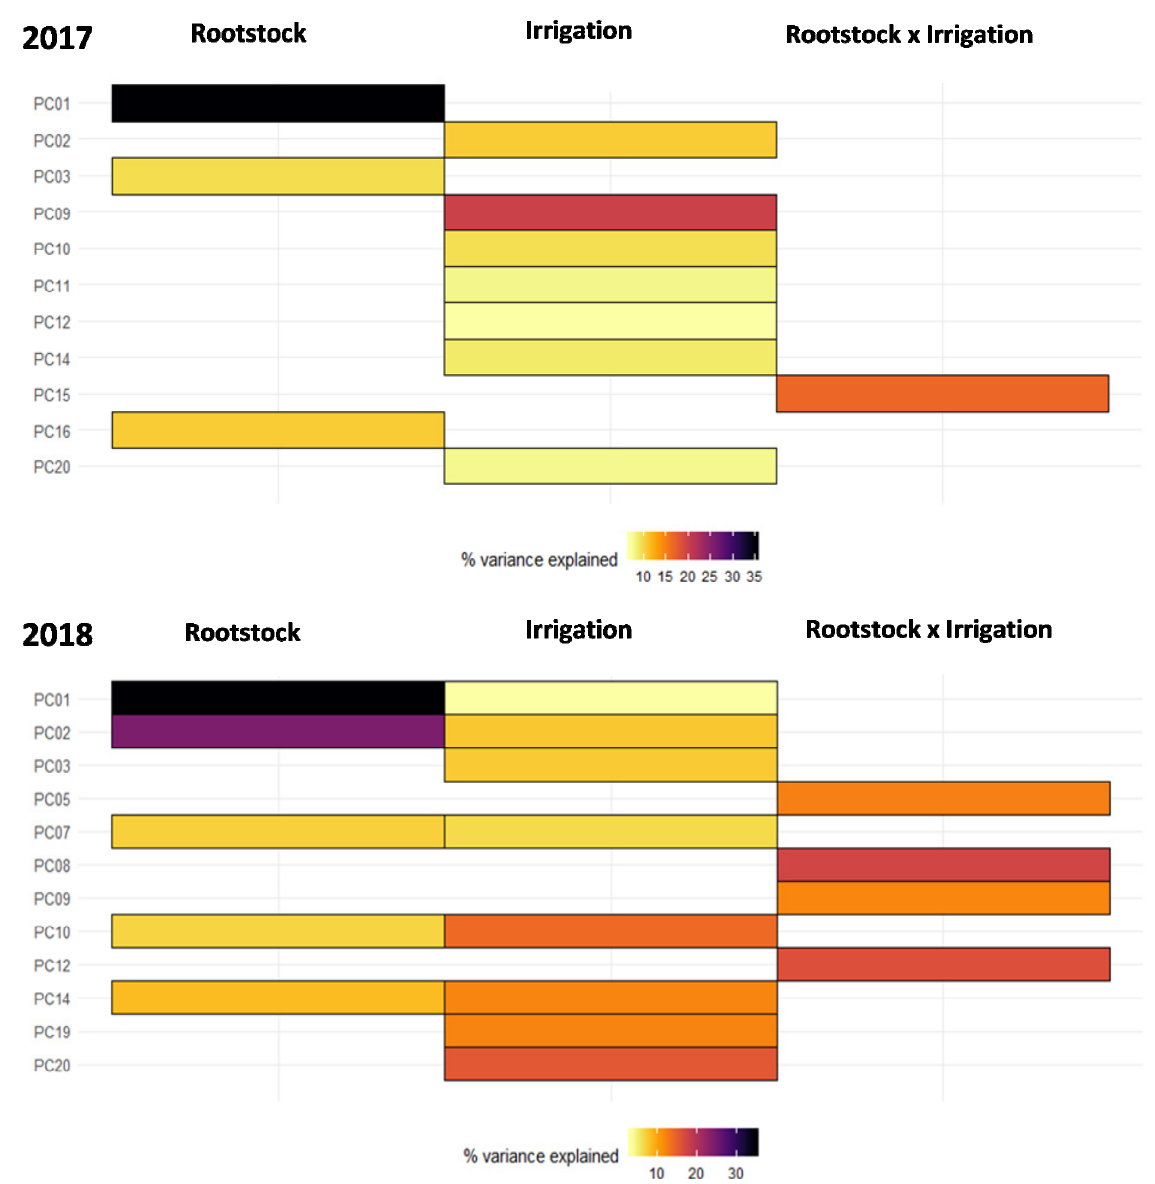
Figure 5. A linear model was estimated for wine 2017 and 2018 PCs 1 to 20. The model included rootstock (own-rooted, ‘1103P’, ‘3309C’, ‘SO4 ′ ), irrigation (Full, RDI, None), and rootstock by irrigation interaction. The 20 PCs capture 85.79% and 78.34% of the variance in 2017 and 2018. Only the factors which explained a significant portion of the variance ( p < 0.05) are plotted. The percent variation explained by each factor is indicated using color.